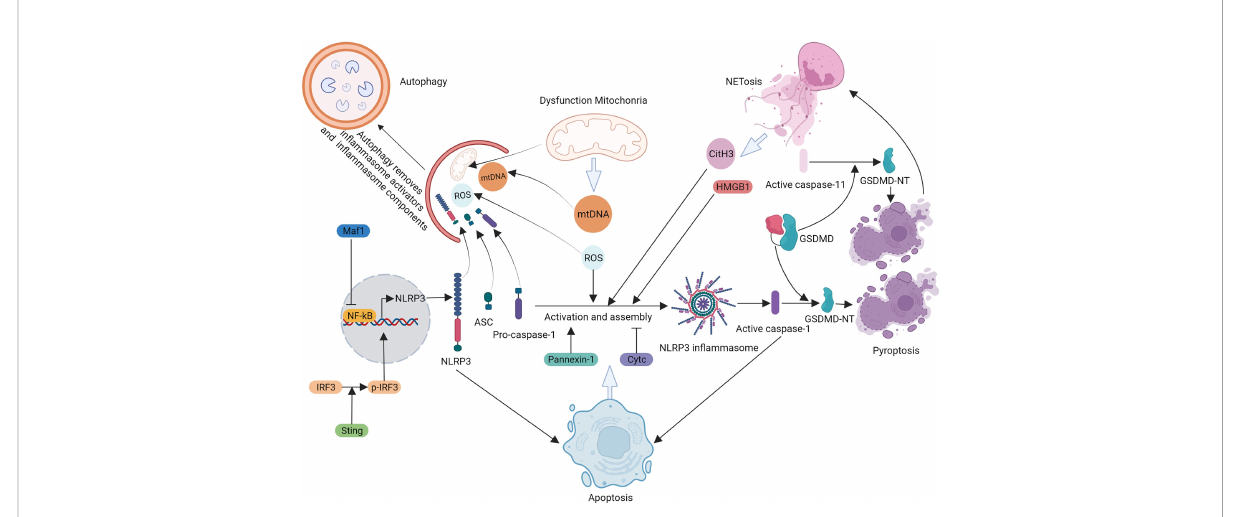
FIGURE 4 Crosstalk between pyroptosis and other programmed cell deaths under